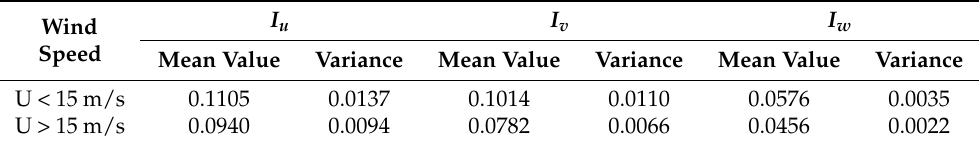
Table 5. Statistical value of the wind turbulence intensity (100